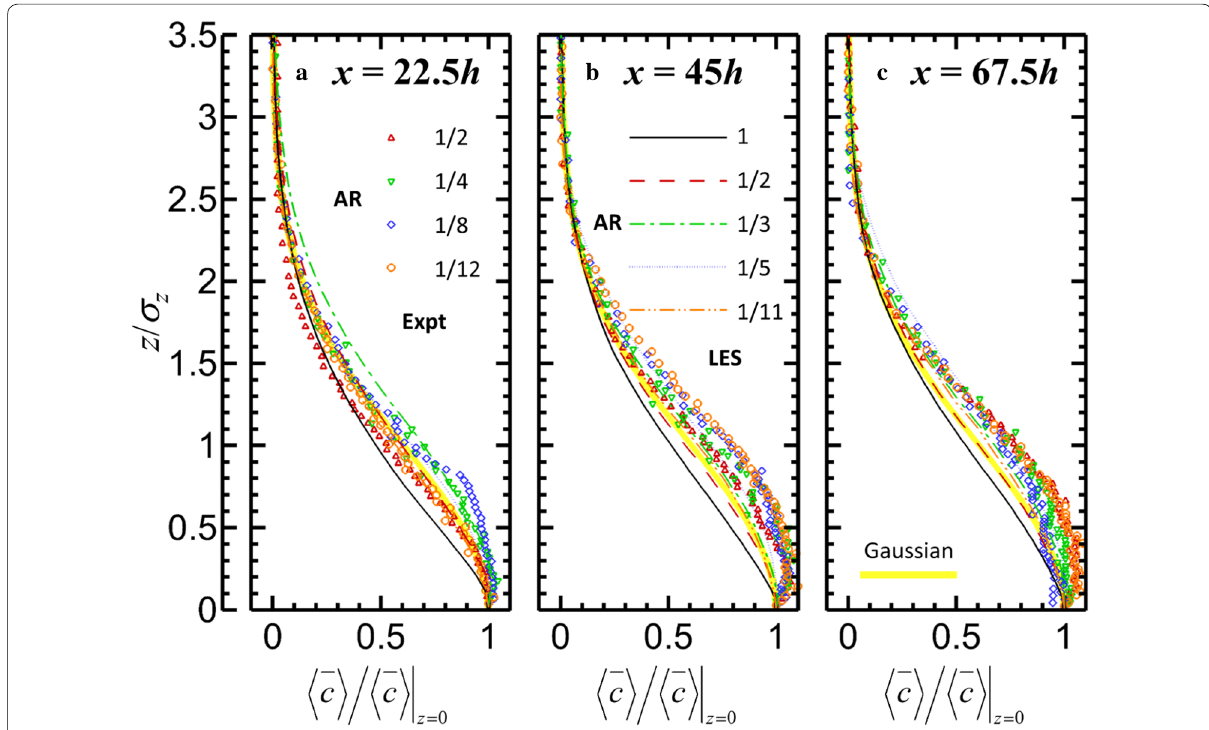
Fig. 5 Dimensionless tracer‑concentration (cid:31) c (cid:30) profiles plotted as functions of wall‑normal distance z at x